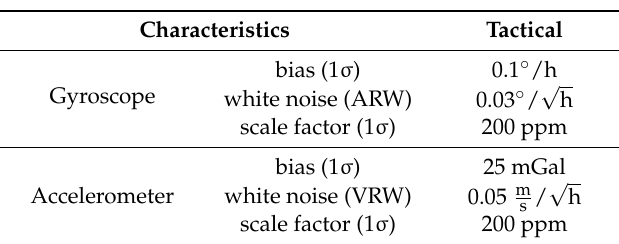
Table 1. Characteristics of the